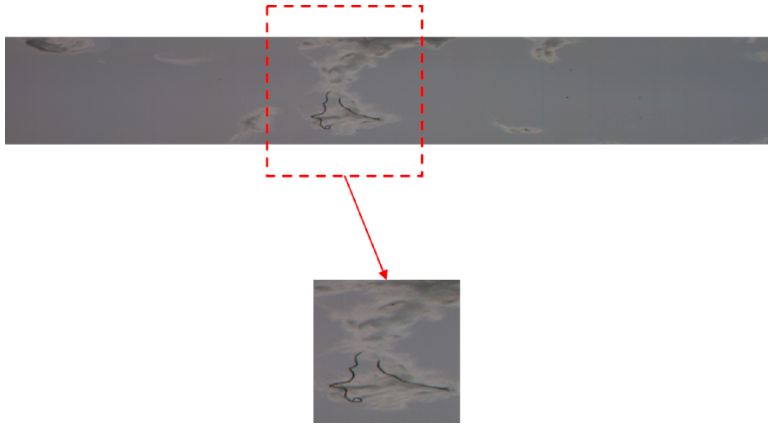
Figure 6. Taking the sample slice (128 × 128) from the original image (128 × 2096).